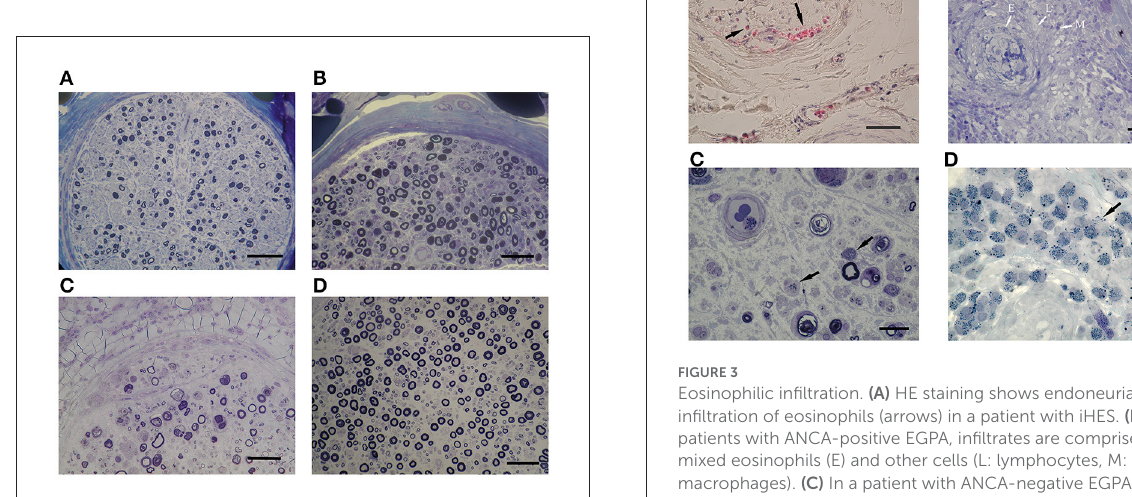
FIGURE1 Nerve degeneration and myelinated nerve fiber loss. EPON-embedded section with toluidine-blue staining in a case of idiopathic hypereosinophilic syndrome (iHES) (A) ANCA-positive EGPA (B) and ANCA-negative EGPA (C) . Myelinated fiber density was better preserved in the ANCA-positive EGPA sample (B) than th in iHES (A) or ANCA-negative EGPA (C) . No differences in the ratios of axonal degeneration were observed among all three groups. A normal nerve is shown for reference (D) . ANCA, anti-neutrophil cytoplasmic antibodies; EGPA, eosinophilic granulomatosis with polyangiitis.